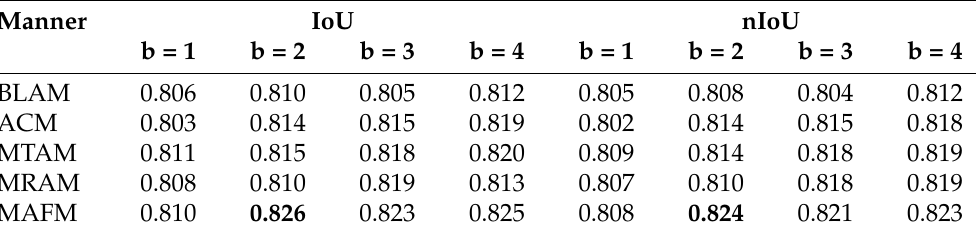
Table 6. Performance comparison of different fusion modules on the IDTAT dataset.